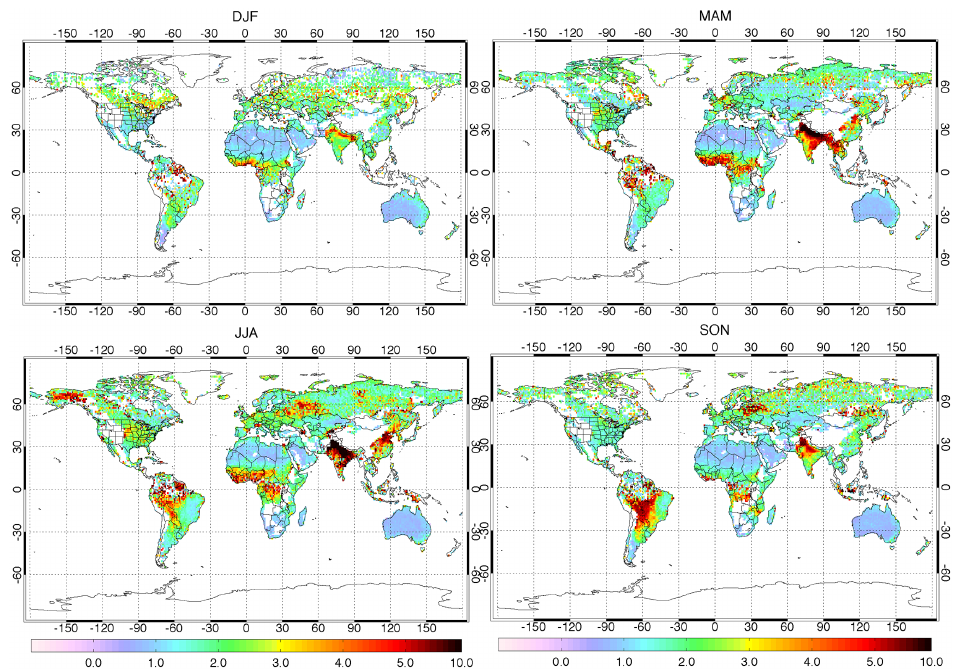
Figure 7. AIRS NH 3 VMRs at 918hPa averaged between September 2002 and August 2015 for December–January–February (DJF, upper left panel), March–April–May (MAM, upper right panel), June–July–August (JJA, lower left panel), and September–October–November (SON, lower right panel), with DOFS greater than 0.1 and no cutoff limit for the VMRs. Red/purple colors indicate relatively high/low NH 3 VMRs.